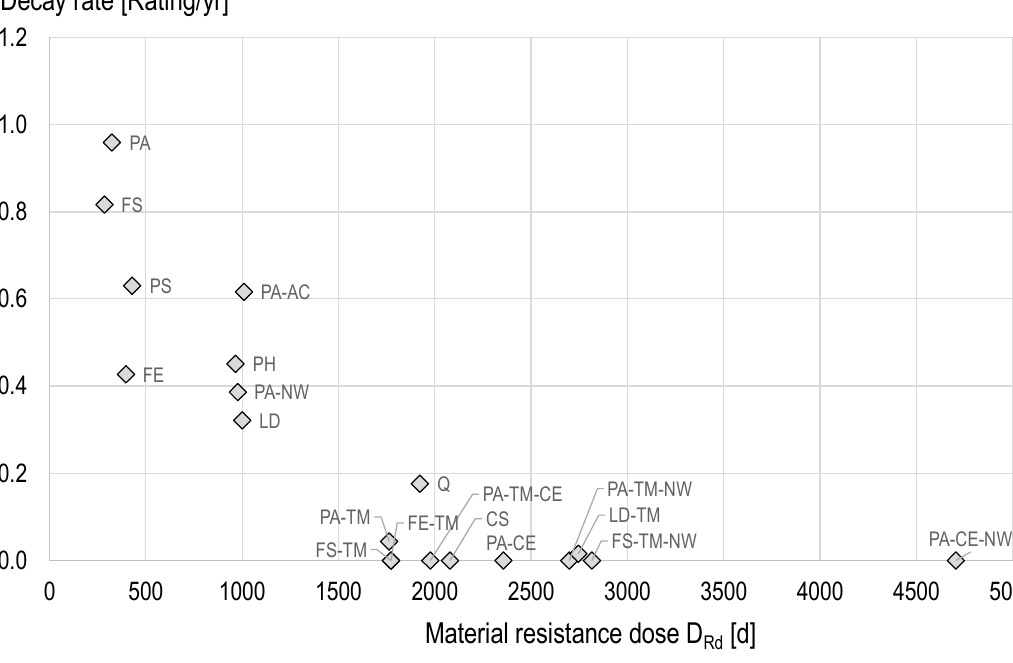
Figure 7. Mean decay rate of the decking at the model house unit in Ljubljana versus the material resistance dose D Rd.